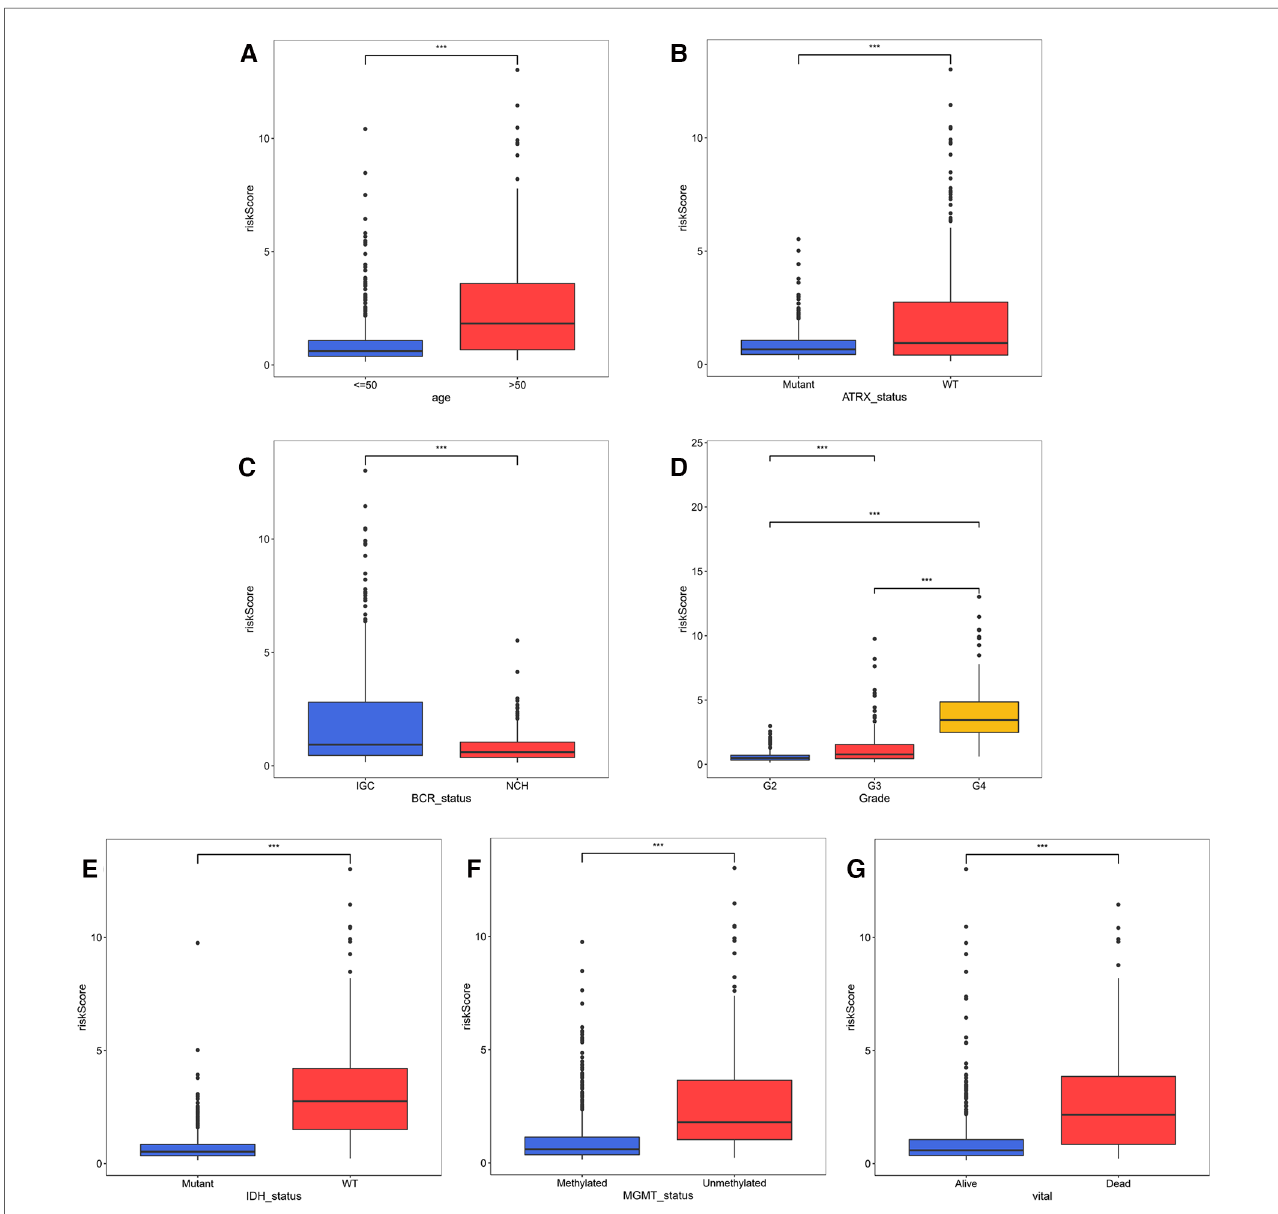
FIGURE 5 Correlation analysis of risk model and clinical factors ( A – D ) comparison of risk scores of different clinical subgroups of TCGA glioma